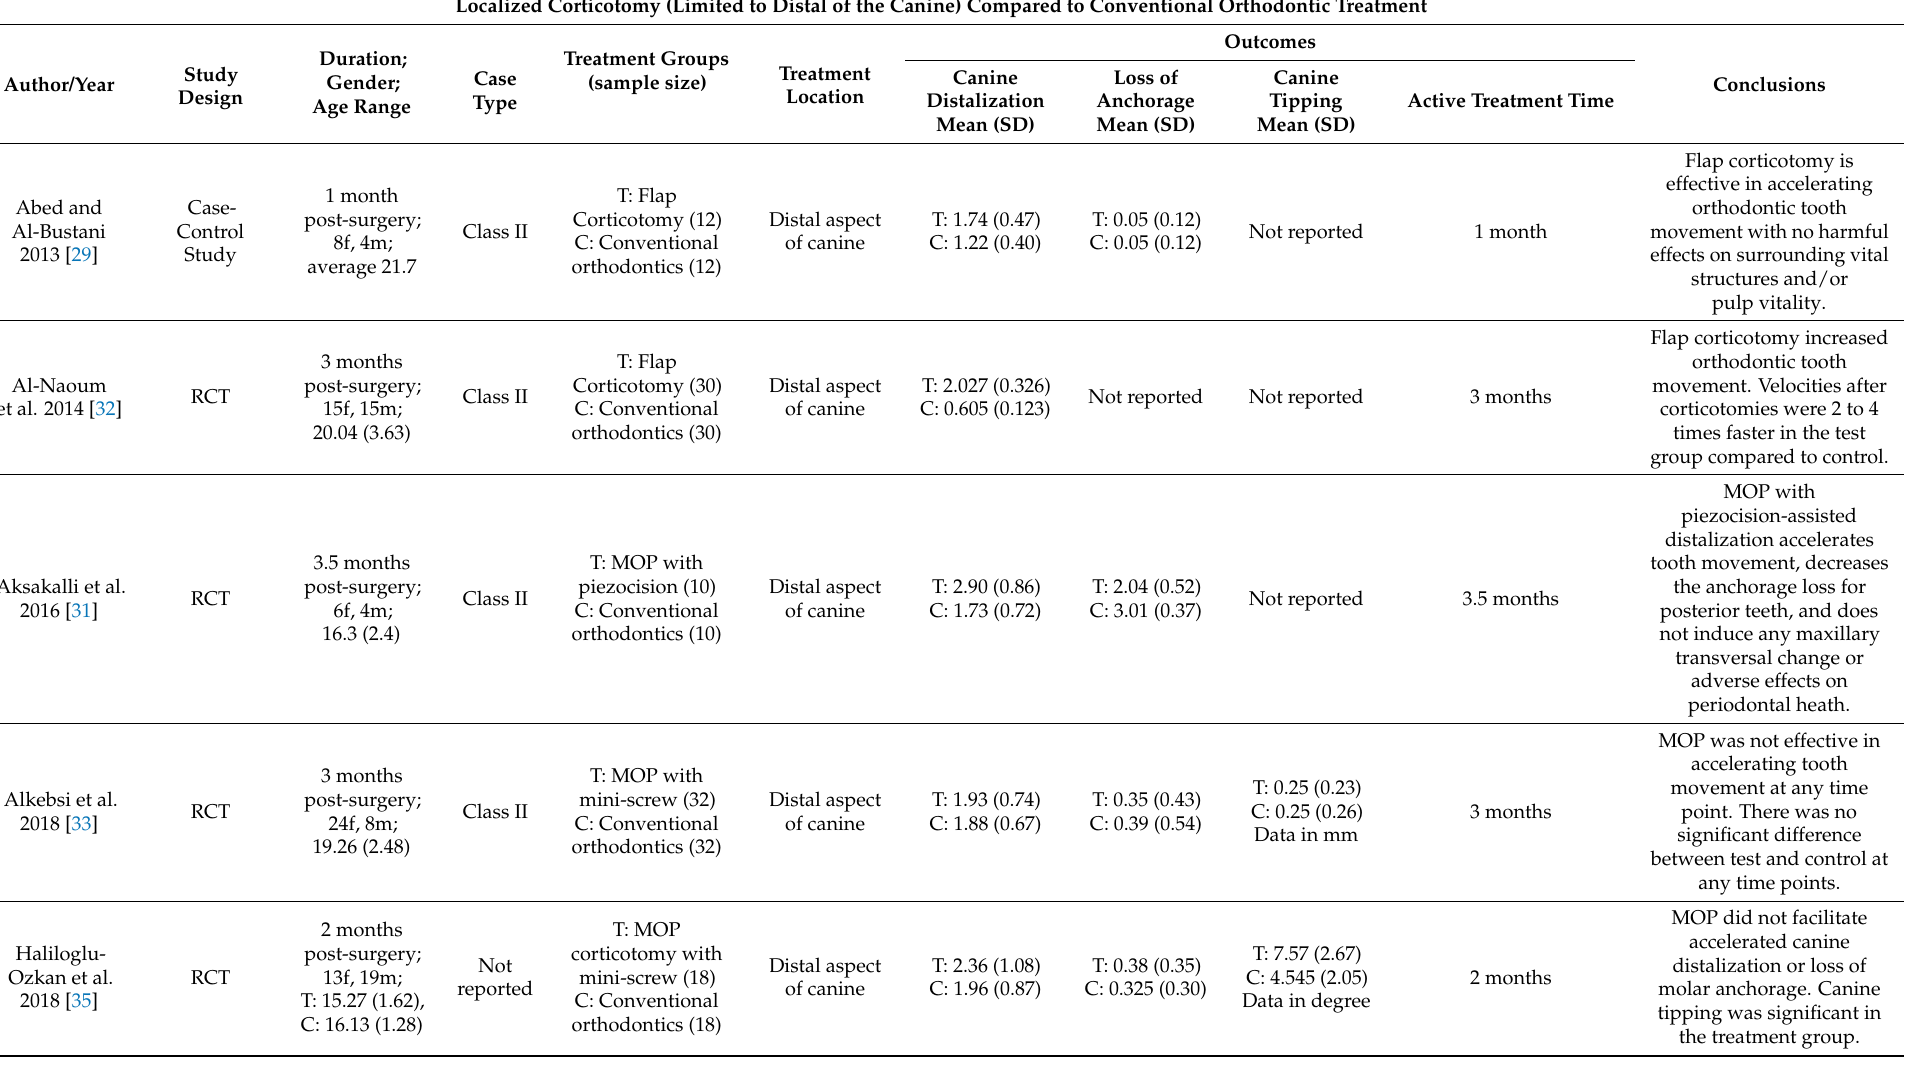
Table 2. Features of the included articles; MOP: